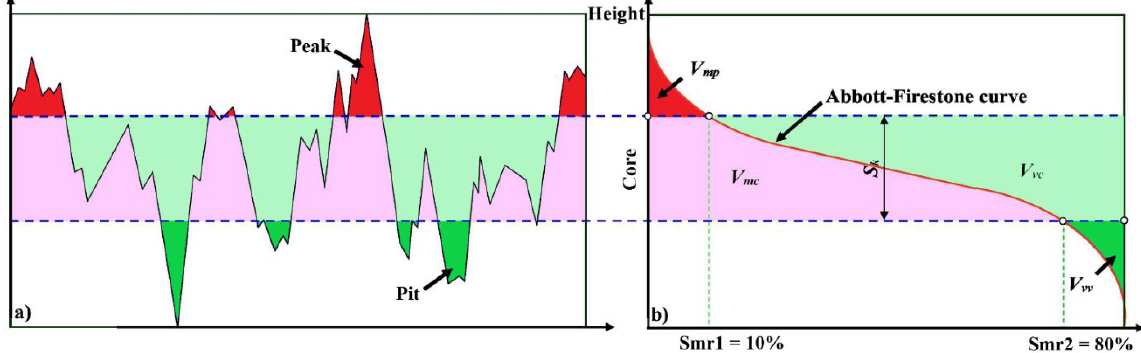
Figure 5. Graphical presentation of the functional (volume) parameters: ( a ) an exemplary surface profile; ( b ) functional (volume) parameters of Abbott–Firestone curve according to ISO 25178.